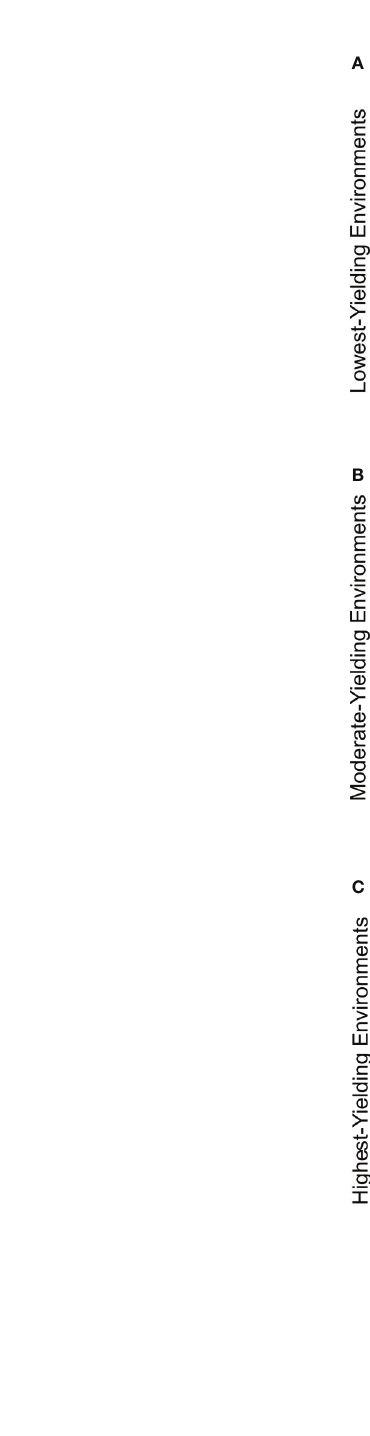
FIGURE 6 Ear type plasticity relationship to predicted yields by yield environment ( A , low; B , moderate; C , high). Right axes indicate % of attainable primary ears observed (65000 ears ha -1 ). Left axes indicate % of attainable secondary ears observed (41000 ear ha -1 ). Bottom axes indicate % of attainable tiller axillary ears observed (43000 ears ha -1 ). Contour shades indicate predicted yield level (purple < 7.5 Mg ha -1 ; lime > 15 Mg ha -1 ). Black star is shown for reference on each plot, indicating 20%, 60%, and 20% of attainable primary ears, secondary ears, and tiller axillary ears, respectively. Insets show relative 95% con fi dence intervals for each coef fi cient estimate (P, primary ears; S, secondary ears; TL, tiller axillary